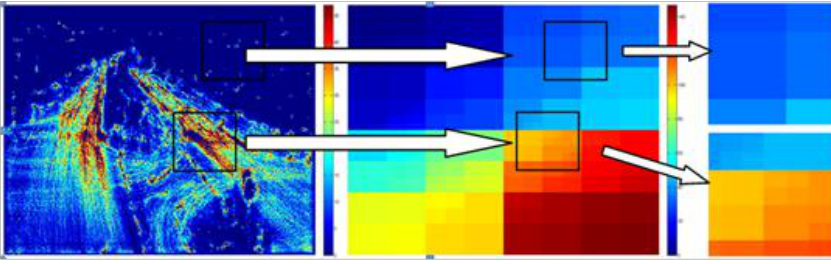
Figure 4. Illustration of the adaptive location quantization results for the intersection